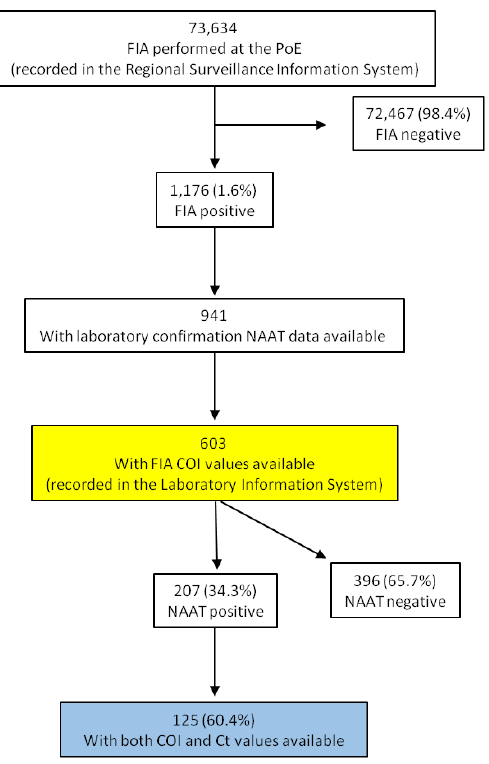
Figure 1. Flow chart of the analysis performed on the records from COVID-19 FIA testing at PoE and NAAT laboratory confirmation. The yellow and blue boxes correspond to the data analyzed in Table 1 and Figure 2, respectively.